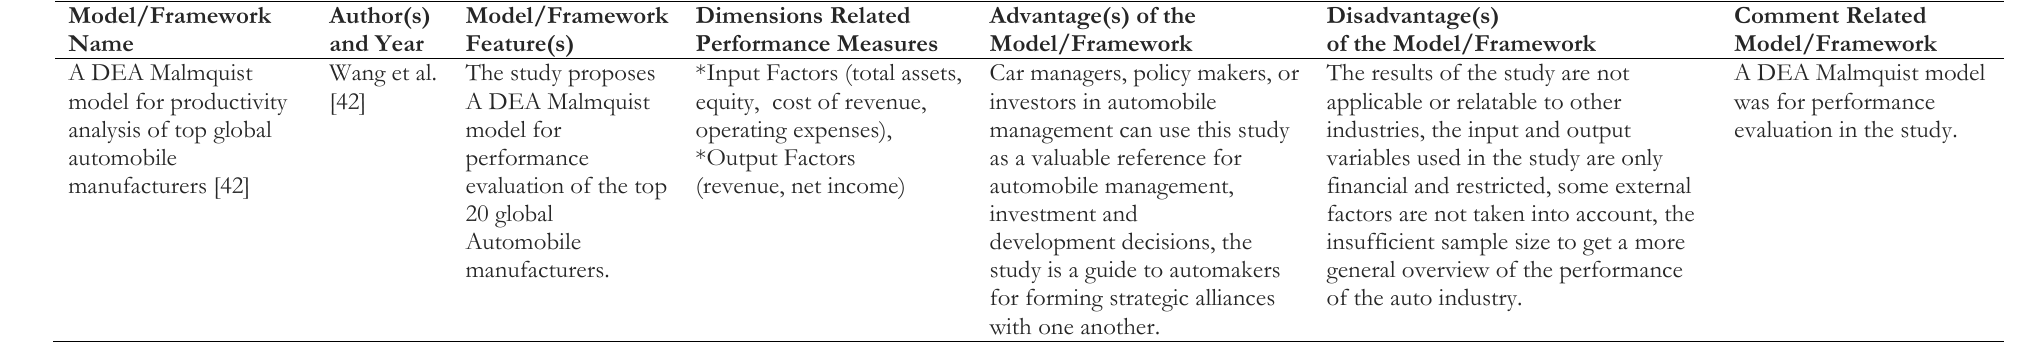
Table 9. Organizational performance measurement models developed in Industry 4.0.